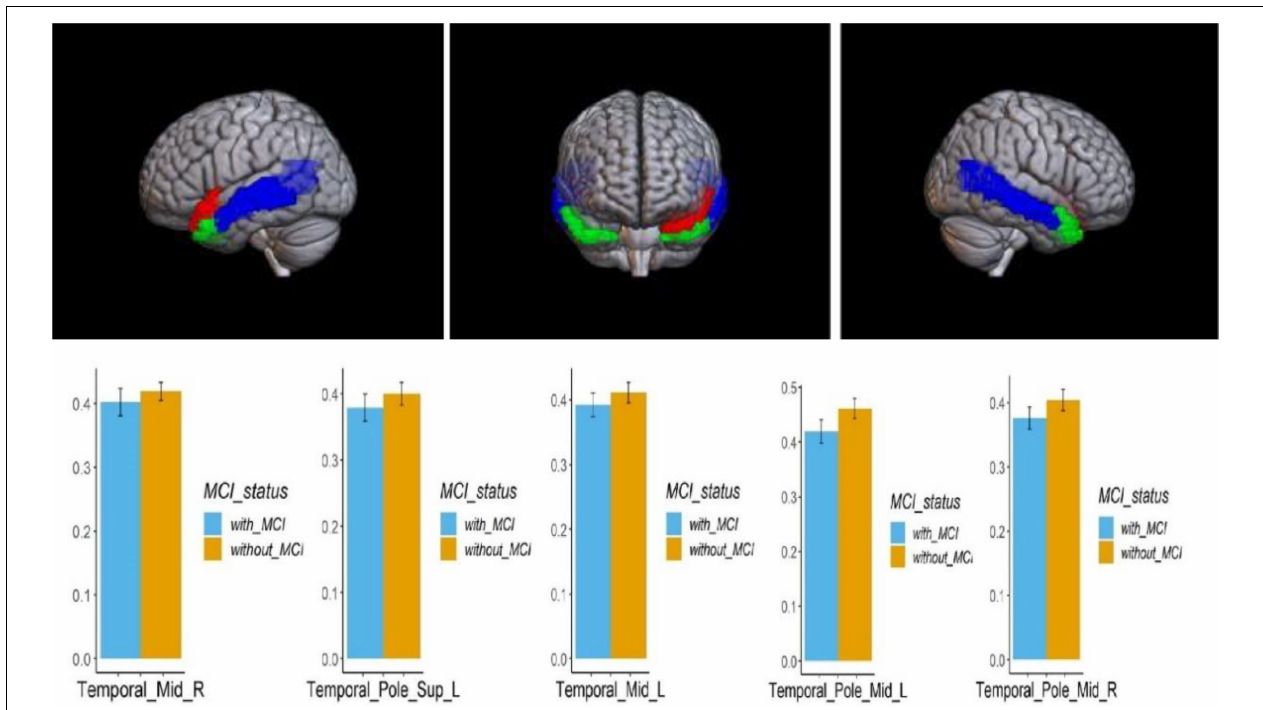
FIGURE 2 | Regional comparison of the GM density between the HA (with MCI) and LA (without MCI) groups. The red area above represents the temporal pole of the left superior temporal gyrus; The blue area represents the bilateral middle temporal gyrus; The green area represents the bilateral middle temporal gyrus and temporal pole ( P < 0.05, Bonferroni corrected). The bars represent the comparison of GM density in the temporal pole of the left superior temporal gyrus, bilateral superior temporal gyrus, and bilateral middle temporal gyrus between the HA group and LA group. L – left hemisphere, R – right hemisphere.